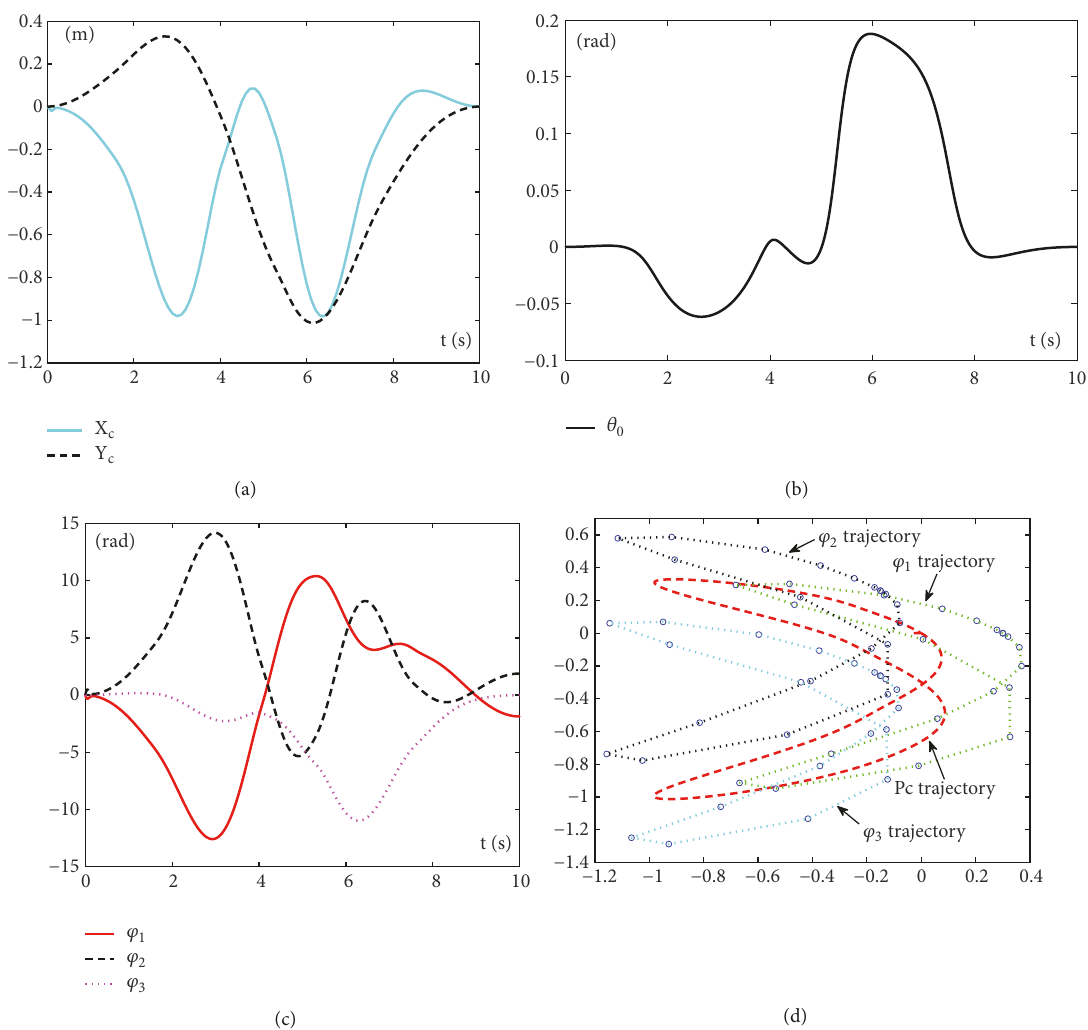
Figure 10: Simulated information about the mobile platform. (a) Position files of the mobile base. (b) Heading angle profiles. (c) Rotating profiles for three wheels. (d) Movable platform trajectories.